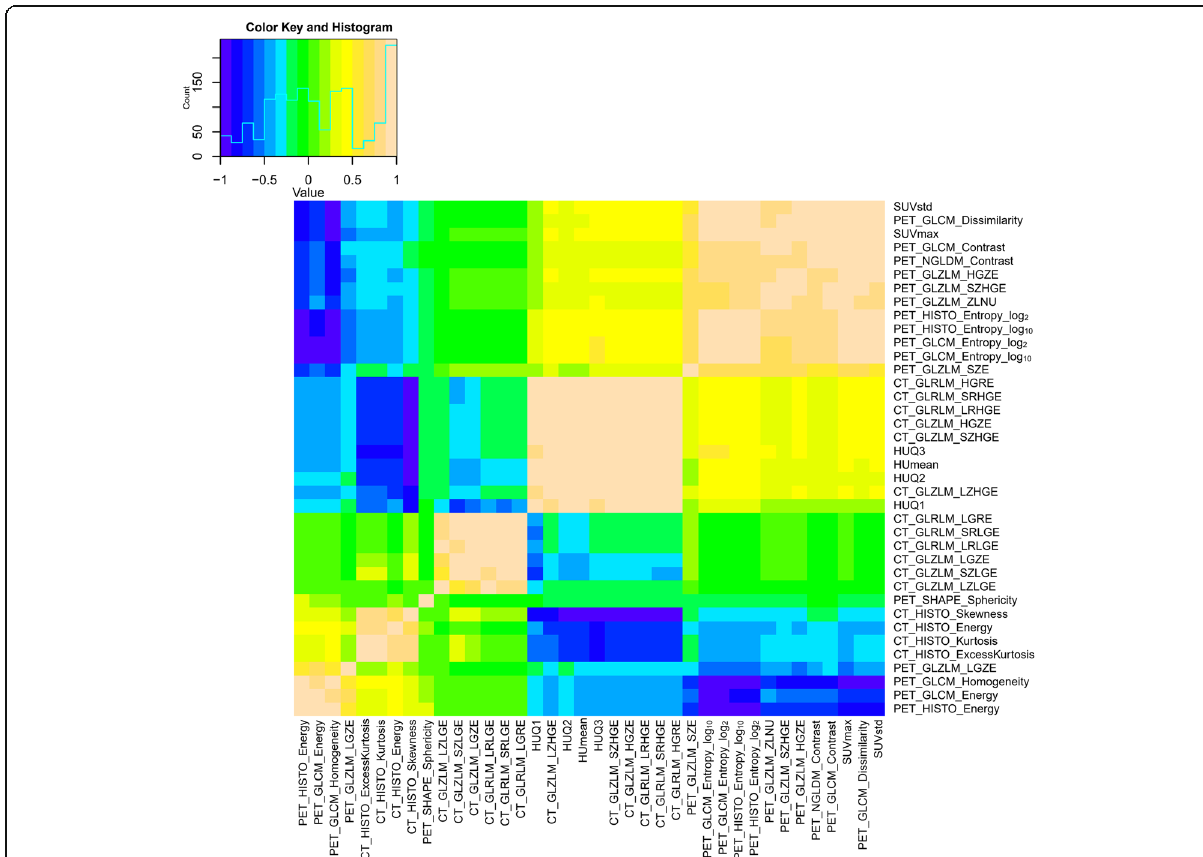
Fig. 3 The Spearman rank correlation method was used to establish a correlation map between each preselected feature. This method integrates CT and PET images. The corresponding coefficients are shown in the heat map, where yellow and blue indicate positive and negative correlations,